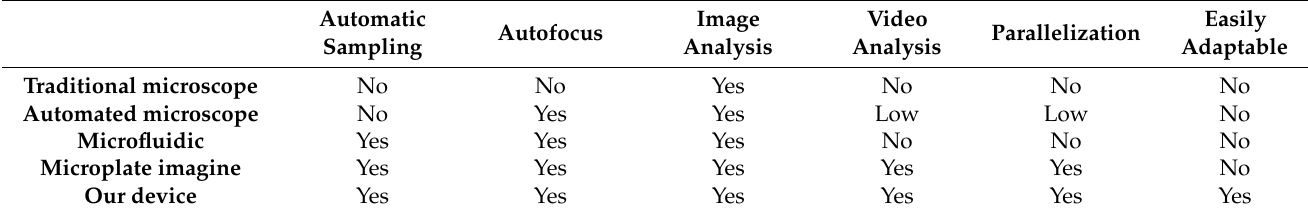
Table 1. Evaluation of the pertinence of the different approaches to meet our